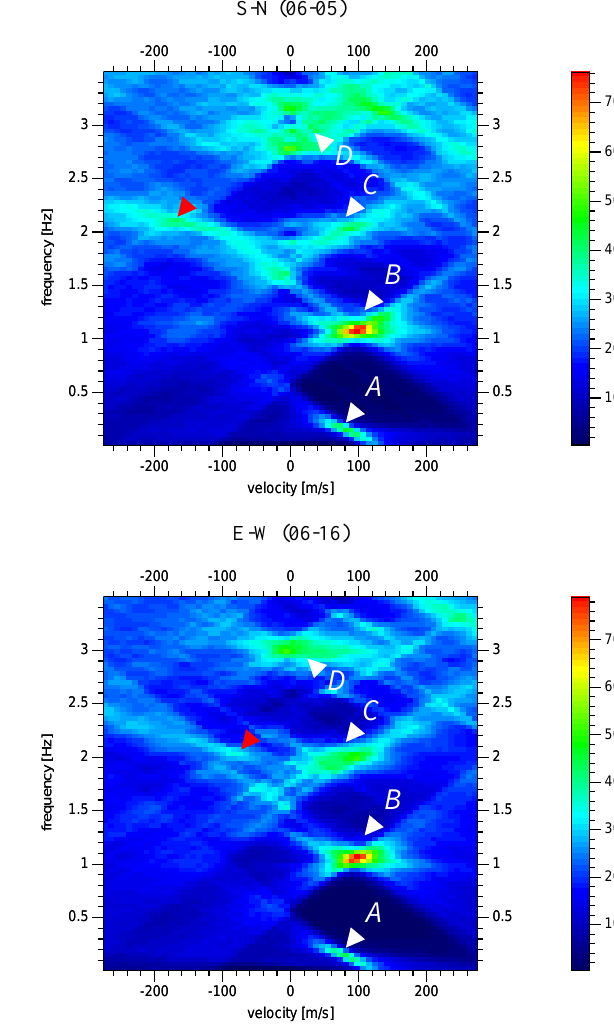
Fig. 9. Radon transform of the phase-frequency distributions from Fig. 6.